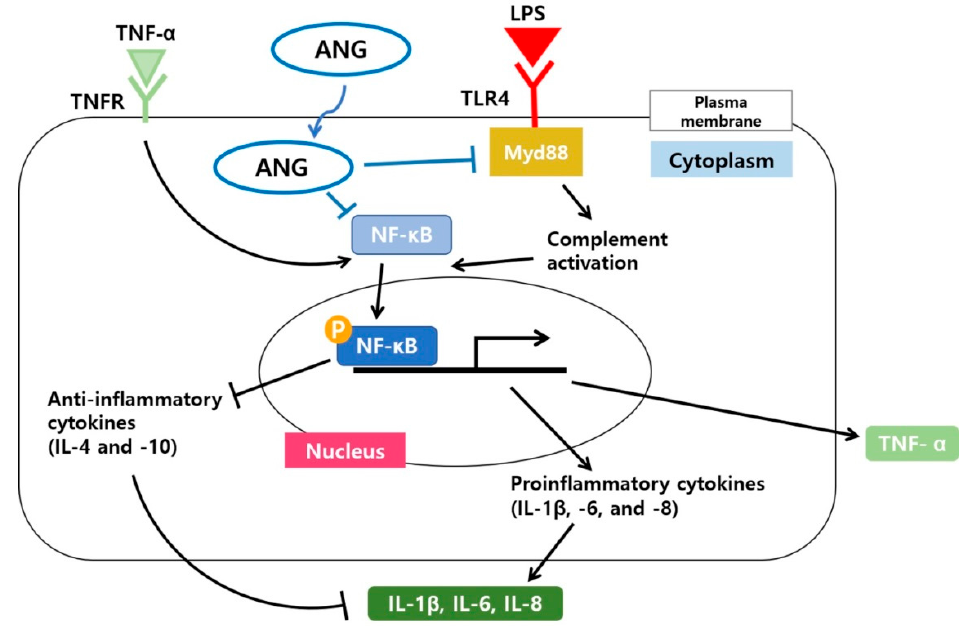
Figure 5. Schematic model illustrating the signaling pathway by which ANG reduces the inflammatory responses involving Myd88 and the nuclear translocation of NF ‐κ B in LPS induced EIU. A possible direct internalization of ANG and the subsequent downregulation of Myd88 and nuclear translocation of NF- κ B result in the reduced mRNA expression of proinflammatory cytokines (IL-1 β , -6, and -8) and increased mRNA expression of anti-inflammatory cytokines (IL-4 and -10). Overall, the cascade underlying the effect of ANG results in suppression of inflammation.